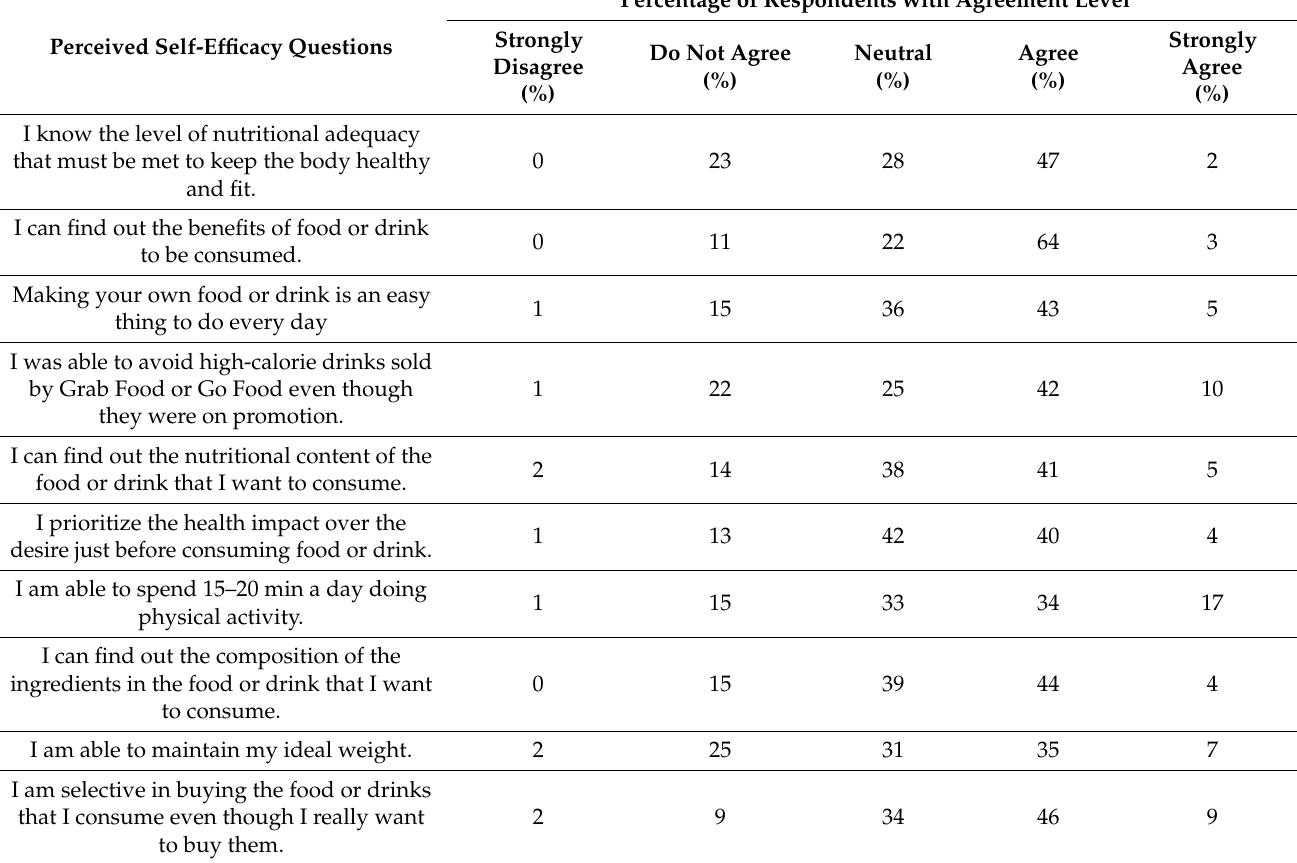
Table 9. Self-efficacy